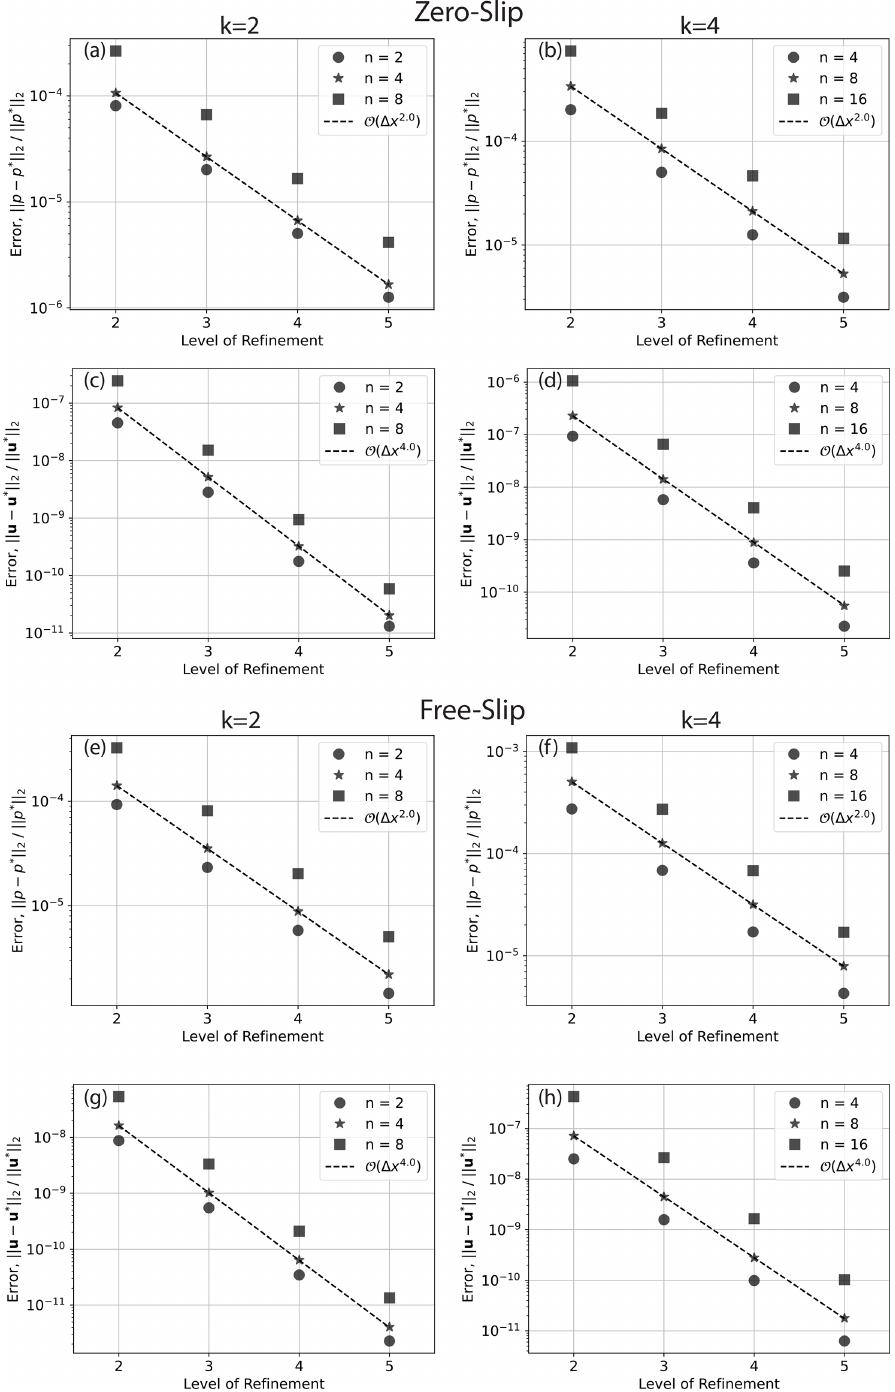
Figure 7. Convergence for 2-D cylindrical shell cases with zero-slip (a–d) and free-slip (e–h) boundary conditions, driven by smooth forcing at a series of different wave numbers, n , and different polynomial orders of the radial dependence, k , as indicated in the legend (see Kramer et al., 2021a, for further details). Convergence rate is indicated by dashed lines, with the order of convergence provided in the legend. For the cases plotted, the series of meshes start at refinement level 1, where the mesh consists of 1024 divisions in the tangential direction and 64 radial layers. At each subsequent level the mesh is refined by doubling resolution in both